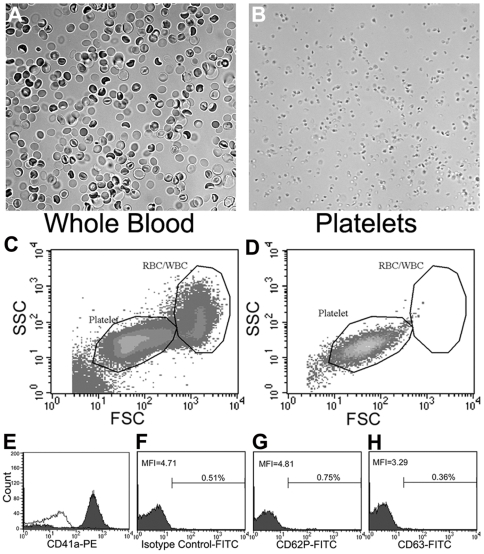
Analysis of platelet quality using light microscopy and flow cytometry.A, B. Light microscopy images of the anti-coagulated whole blood sample (A) and the isolated platelets (B) at 40× magnification. Red blood cells (RBCs) are clearly visible in the anti-coagulated whole blood samples (A), whereas no detectable RBCs were seen in the isolated platelet samples (B). C–E. Flow cytometric analyses of anti-coagulated whole blood (C) and the isolated platelets (D, E). Forward- and side-scatter density plots show that RBC/WBC and platelets populations are clearly distinguishable based on their respective light scatter patterns. E. Flow cytometric analysis of isolated platelets upon staining with anti-CD41a mAb (filled histogram) as compared to an isotype control (open histogram). F–H. Flow cytometric analyses of the isolated platelets showing that the platelets are in a quiescent state. The CD41a+ platelets were further analyzed for markers of platelet activation using antibody against CD62P (P-selectin) (G) or against CD63 (type III lysosomal glycoprotein) (H), both of which showed no increase as compared to an isotype control antibody (F). The determined percent positive events (Vs isotype control) and MFI are indicated in each histogram.